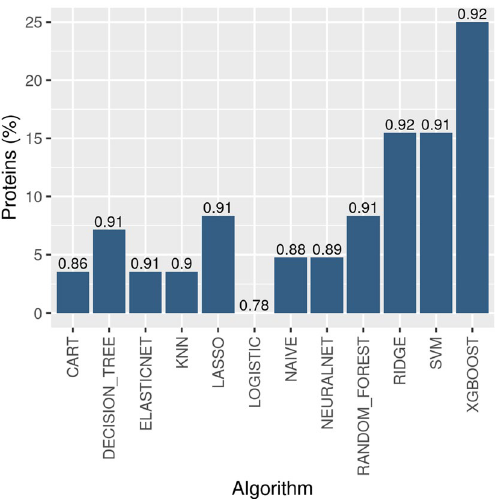
Figure 3. Best performing algorithms for F1-measure. For each algorithm, the Y-axis indicates the percentage of kinases for which the corresponding model in the X-axis achieved better performance compared to the others. Whereas the values shown at the top of the bars represent the overall average of F1 and each algorithm for all proteins in